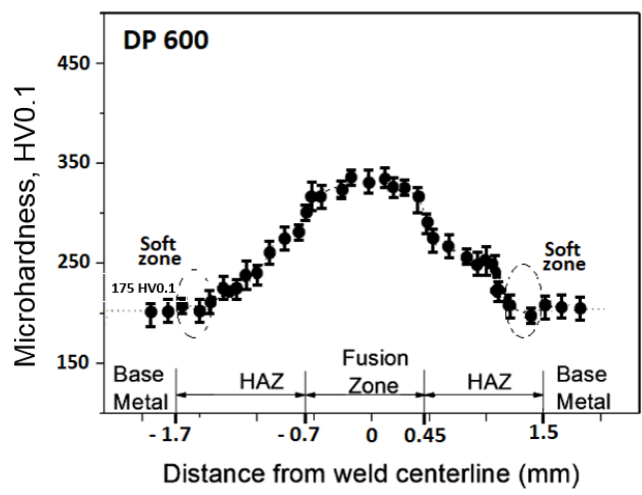
Figure 5. Weld microhardness profiles sample B (DP600).